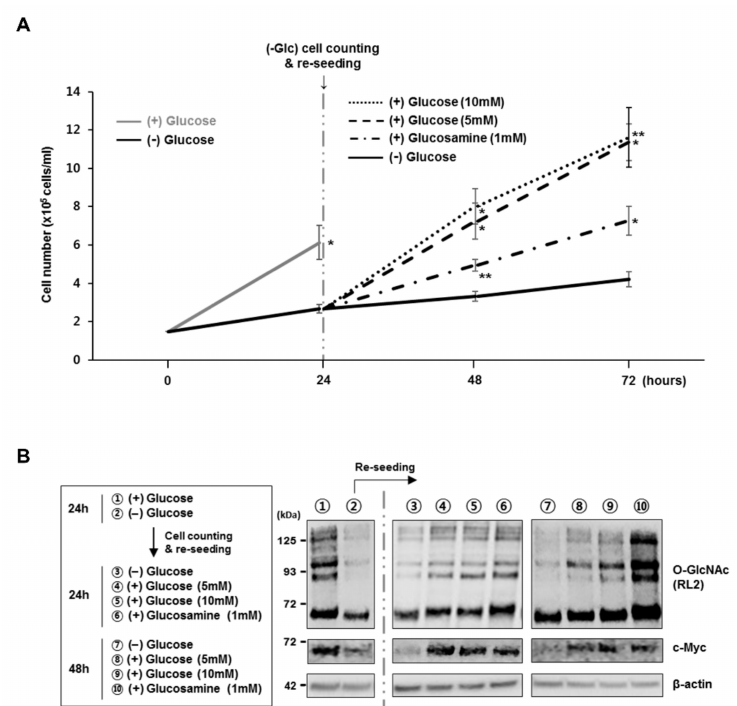
Figure 4. Decreased O-GlcNAc levels in pre-B cells due to the restriction of glucose uptake downregulates c-Myc expression and subsequently inhibits cell proliferation. ( A , B ) PD36 pre-B cells cultured in glucose-depleted media for the first 24 h were subsequently cultured following the re-introduction of glucose or glucosamine for another 48 h. ( A ) Cell growth in di ff erent culture conditions was monitored over 72 h. Data are represented as mean ± SD ( n = 3). Comparisons were performed against the cell number in glucose-depleted media at each time point. Significance is annotated as * p ≤ 0.05, ** p ≤ 0.01. ( B ) The workflow of cell seeding and positions for western blot (left). Representative western blot showing changes in c-Myc protein levels and O-GlcNAcylation